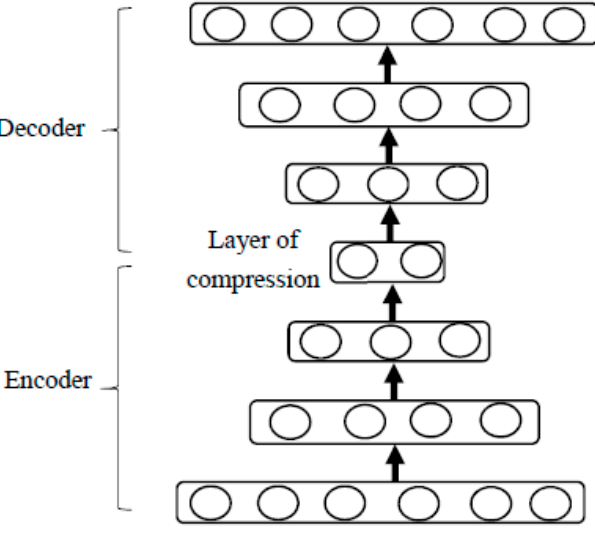
Figure 4. Deep autoencoder of the local database.